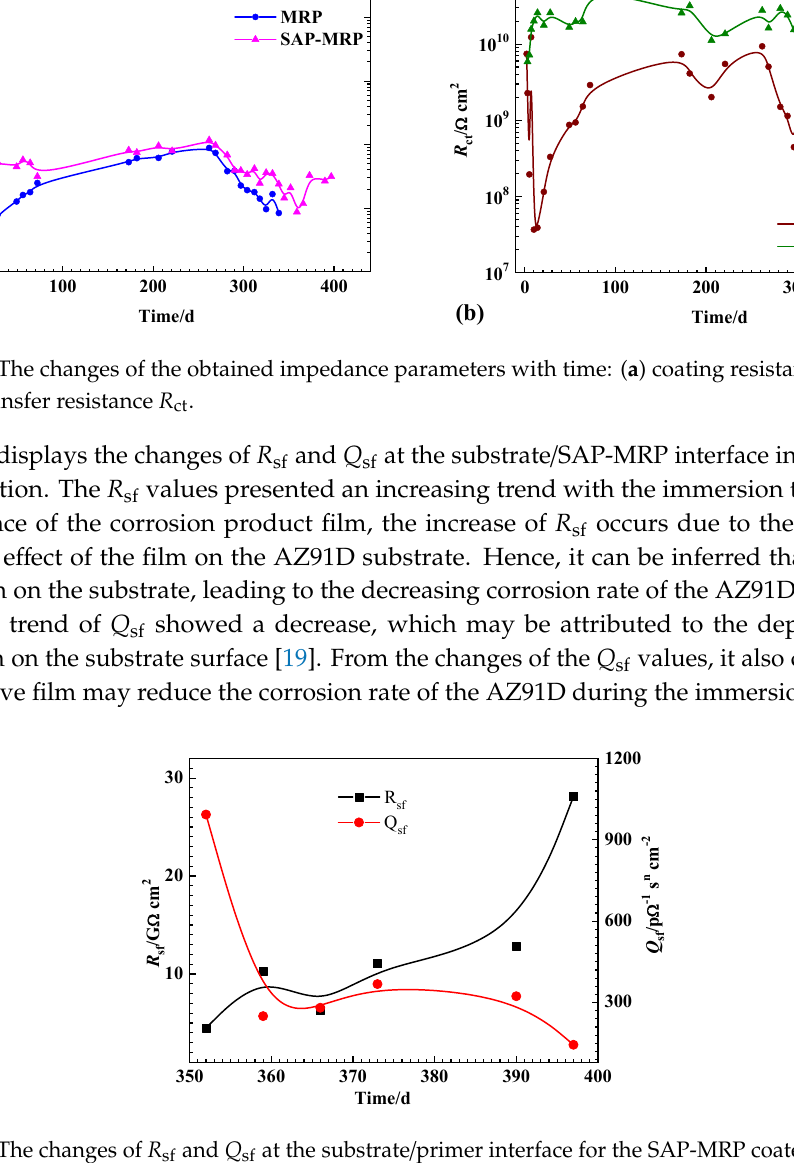
Figure 6. The changes of the obtained impedance parameters with time: ( a ) coating resistance, R c ; ( b ) charge-transfer resistance R ct .